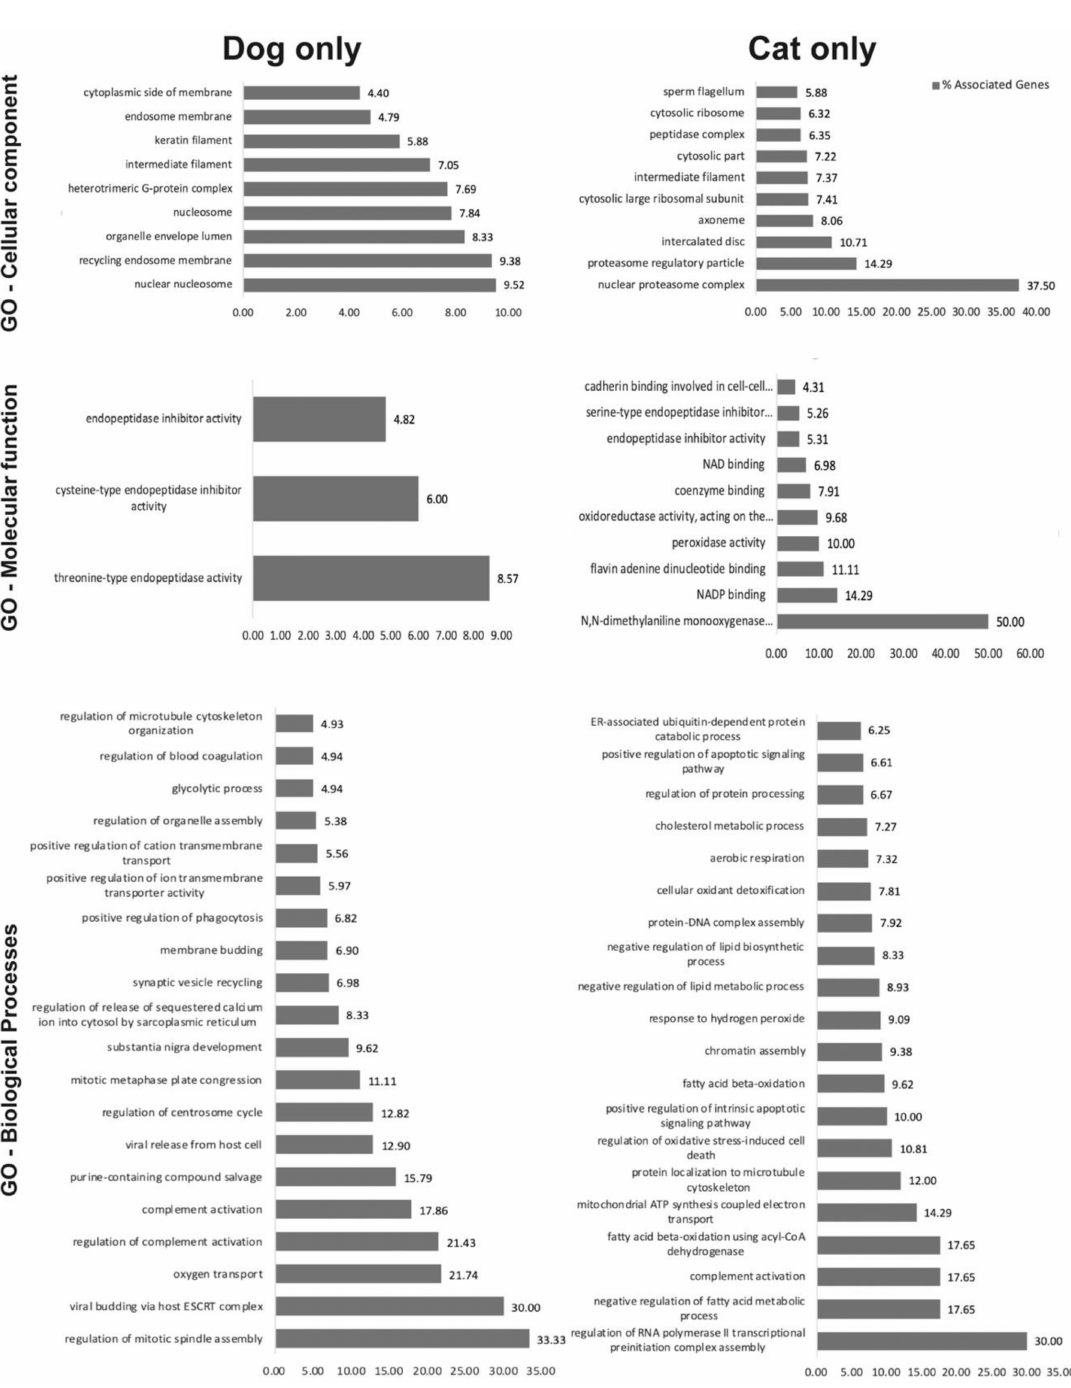
Figure 3. Top enriched gene ontology (GO) of cellular components, molecular function, and biological process terms for unique proteins in the dog and cat oEVs, analyzed by the Cytoscape plug-in ClueGO ( p < 0.05) [38]. 2.3. oEVs Improve Sperm Post-Thaw Motility in the Red Wolf but Not in the Cheetah Red wolf and cheetah sperm were thawed in the presence or absence of oEVs recovered from dogs or cats, respectively, during the proestrus (ProE), pre-ovulatory (PreO), peri-ovulatory (PeriO) or post-ovulatory (PostO) stages. The overall total motile cryopreserved red wolf sperm decreased from 80 ± 10% (fresh) to 61 ± 18% (immediately post-thaw; p = 0.0782, t-test). Post-thaw total motile red wolf sperm incubated in dog PeriO or PostO oEVs was significantly higher than the control